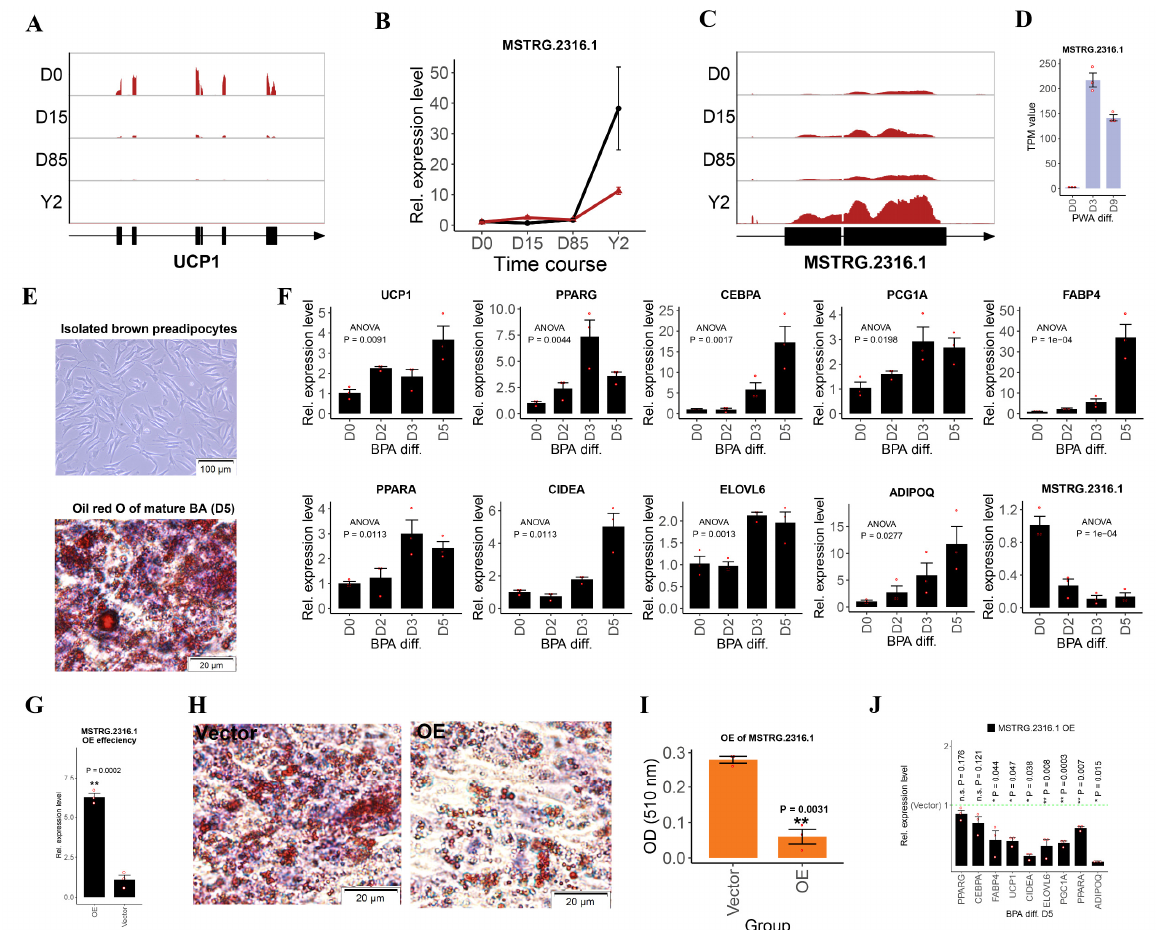
Figure 4. Selection of lncRNA candidates and functional validation of lncRNA MSTRG.2316.1. ( A ) The read coverage and gene structure of the UCP1 gene. The black blocks indicate the exons and the right direction of the arrow indicates the gene located in the positive strand. ( B ) qRT-PCR validation of lncRNA MSTRG.2316.1. The red line represents ssRNA-seq TPM values and the black line represents relative expression levels of qRT-PCR. ( C ) The read coverage and transcript structure of MSTRG.2316.1. ( D ) MSTRG.2316.1 upregulated during white adipocyte differentiation. ( E ) The upper panel indicates that the cell morphologies of the isolated rabbit brown preadipocytes are fusiform or triangular. The scale bar: 100 µ m. The bottom panel indicates that the Oil red O staining identifies many lipid droplets in mature brown adipocytes after brown preadipocytes differentiating for 5 days. The scale bar: 20 μ m. ( F ) Expression levels of BAT markers and MSTRG.2316.1 at 0 days (D0), 2 days (D2), 3 days (D3) and 5 days (D5) during rabbit brown adipocyte differentiation. One-way ANOVA